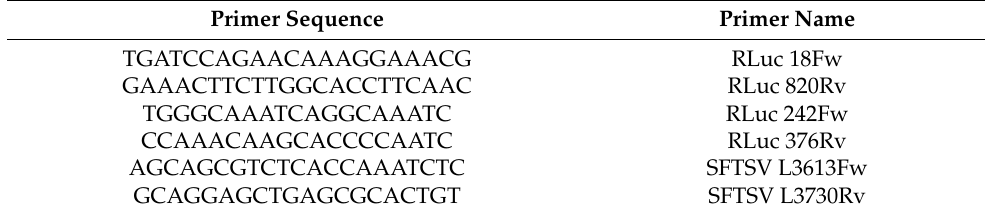
Table 2. Primers used for RT-PCR and qPCR. Primer